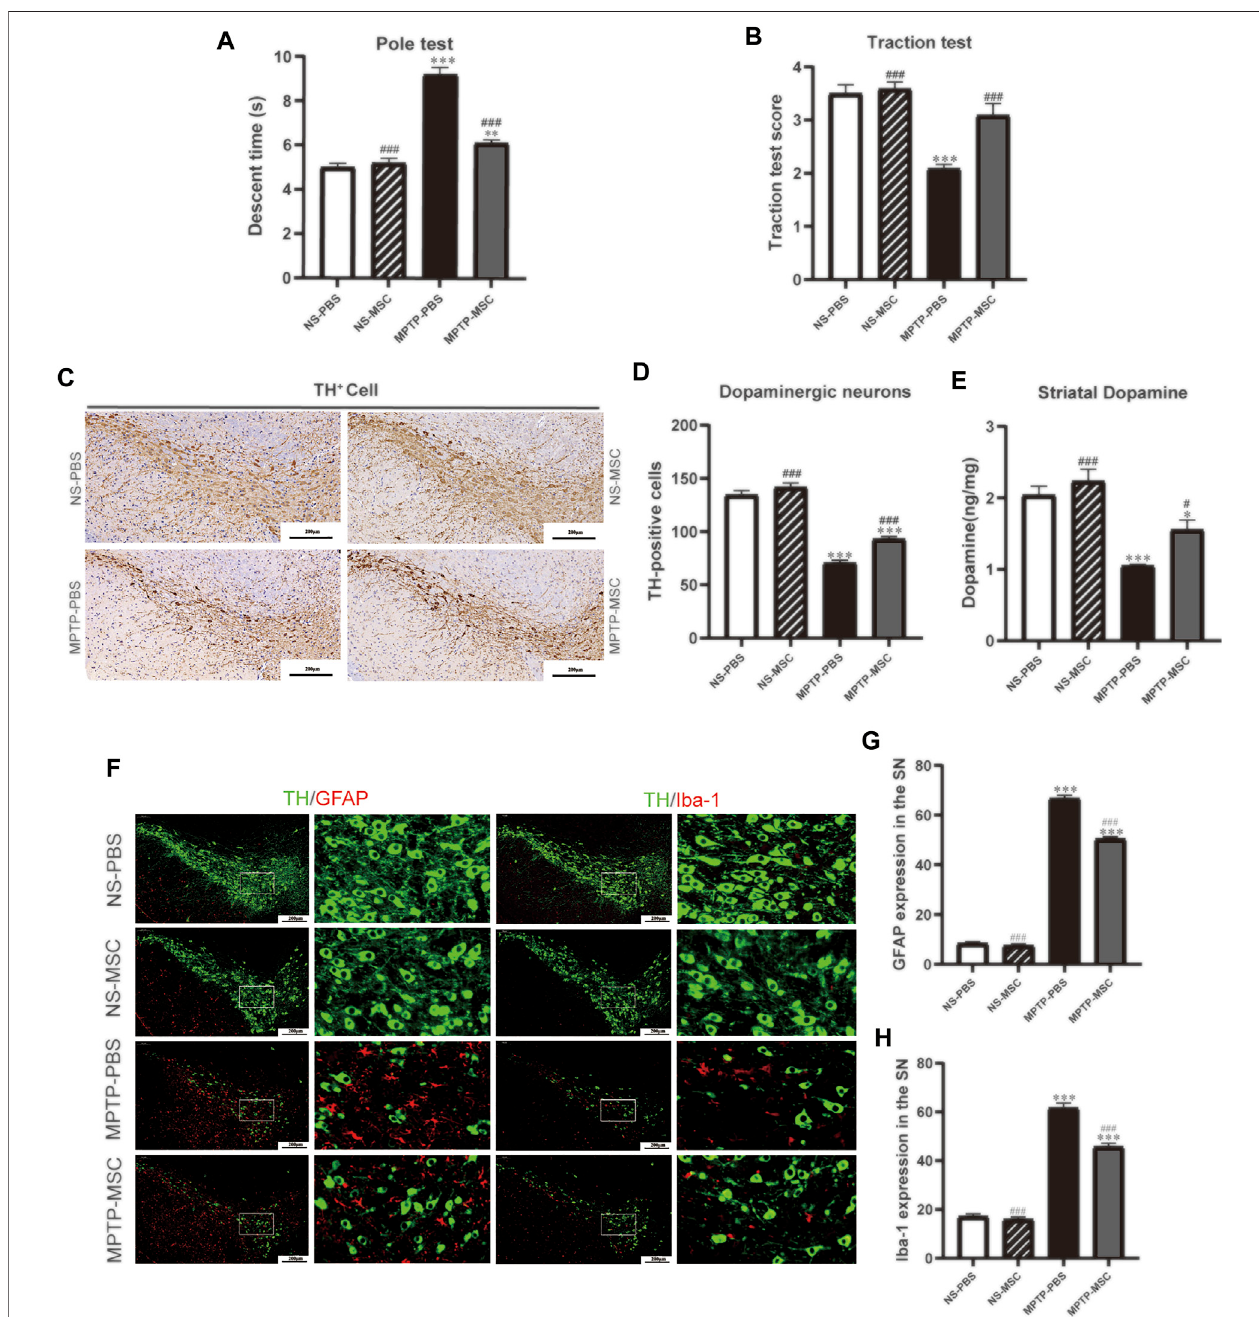
FIGURE 3 | UC-MSCs improved motor function, protected dopaminergic neurons in the substantia nigra and striatum, and alleviated microglia-mediated neuroin fl ammation inMPTP-inducedPDmice. (A) Poletest; (B) tractiontest; (C) Immunohistostainingfortyrosinehydroxylase(TH) intheSN; (D) quantitative analysisof the number ofTH-positive cells intheSN; (E) contentofdopamine wasmeasured byHPLC-MSintheST. Dataof (A , B) ( n (cid:1) 12per group) areexpressed asmean ± SE. Data of (C , D) ( n (cid:1) 3 – 4 per group) are expressed as mean ± SE. Scale bar: 100 μ m (SN). (F) Double immuno fl uorescence staining for TH (green), GFAP (red), and Iba-1(red)intheSN; (G) QuantitativeanalysisofthenumberofGFAPpositivecellsineachgroup; (H) Quantitativeanalysisofthenumberofmicrogliaineachgroup;Data of (F – H) ( n (cid:1) 4 per group) are expressed as mean ± SE. Scale bar: 100 μ m (SN). * p < 0.05, ** p < 0.01, *** p < 0.001 compared with NS-PBS group, ## p < 0.01, ### p < 0.001 compared with MPTP-PBS group by one-way ANOVA.